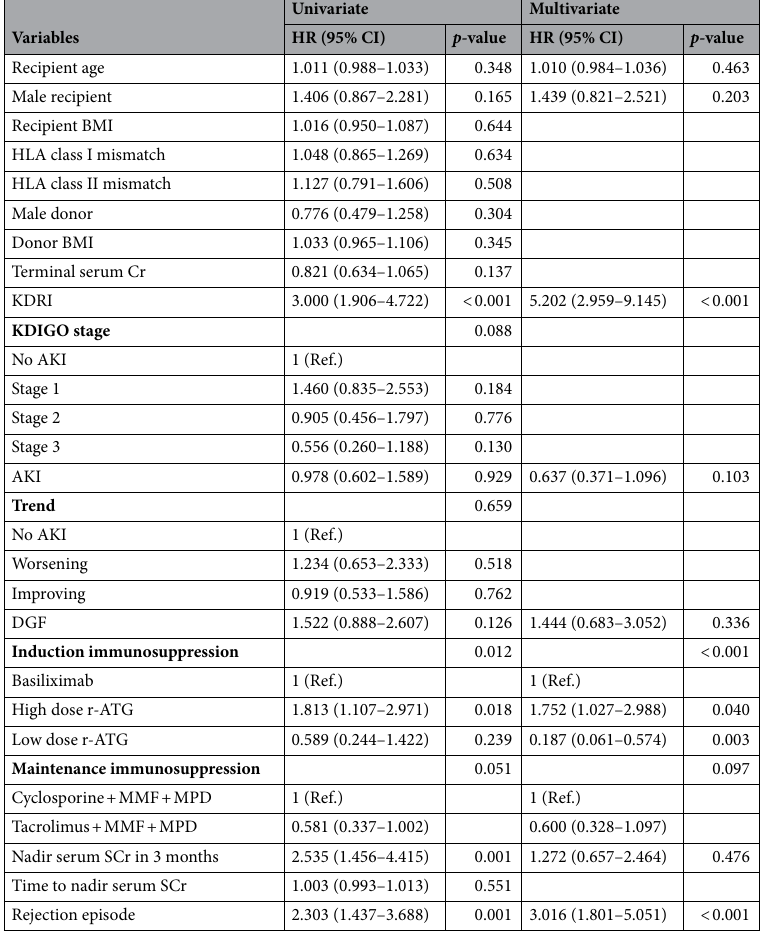
kidney injury, DGF delayed graft function, ATG anti-thymocyte globulin, MMF mycophenolate mofetil, MPD